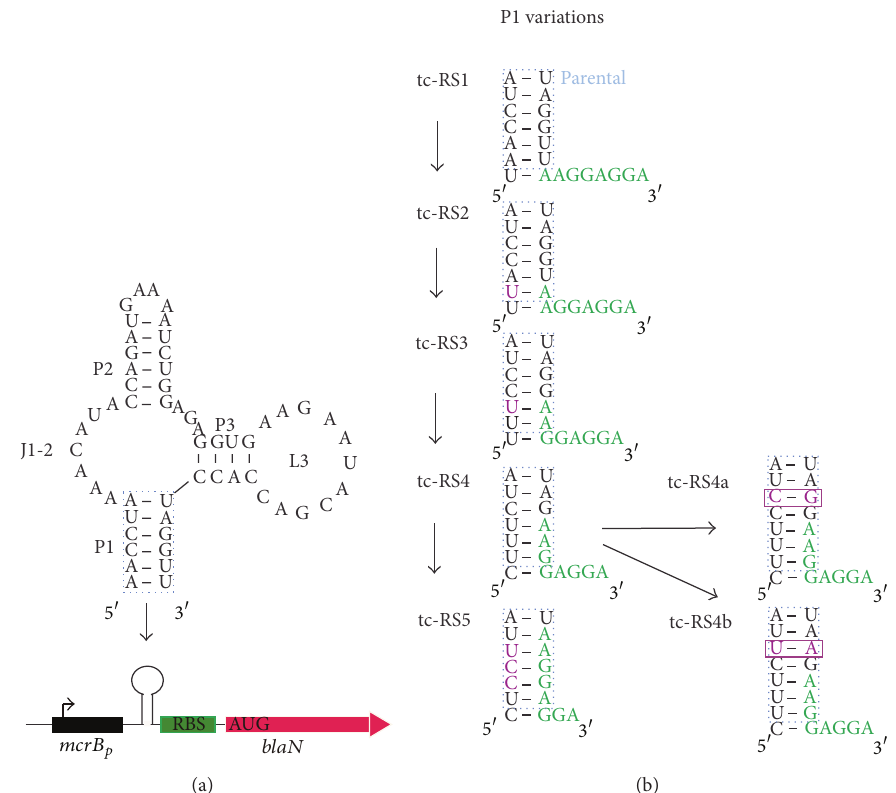
Figure 3: tc-RS-regulated translation of bla mRNA. Left: scheme of tc-RS encoding blaN fusions inserted into the M. acetivorans chromosome; right: tc-RS variants analyzed in this study (tc-RS1 to tc-RS5); for simplicity, only the closing stem P1 and the adjacent RBS (in green) are shown and bases changed from the precursor construct are indicated in violet; mcrB